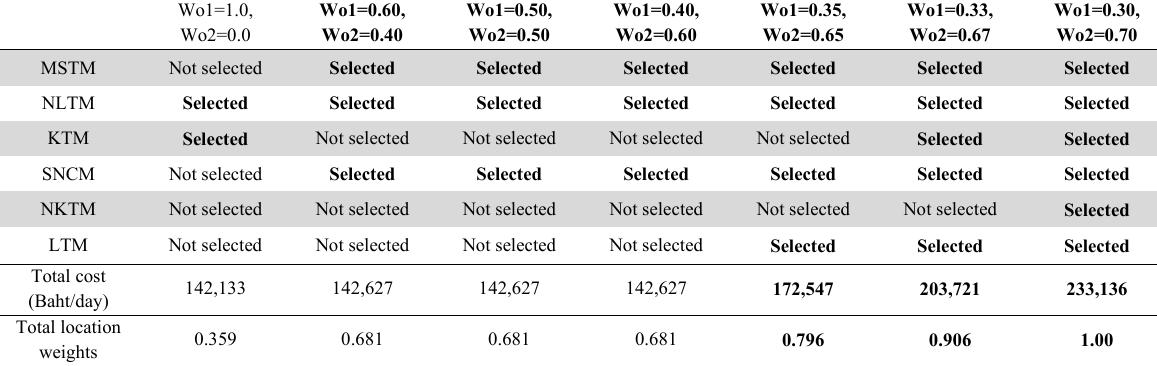
Sensitivity analysis for different levels of objective